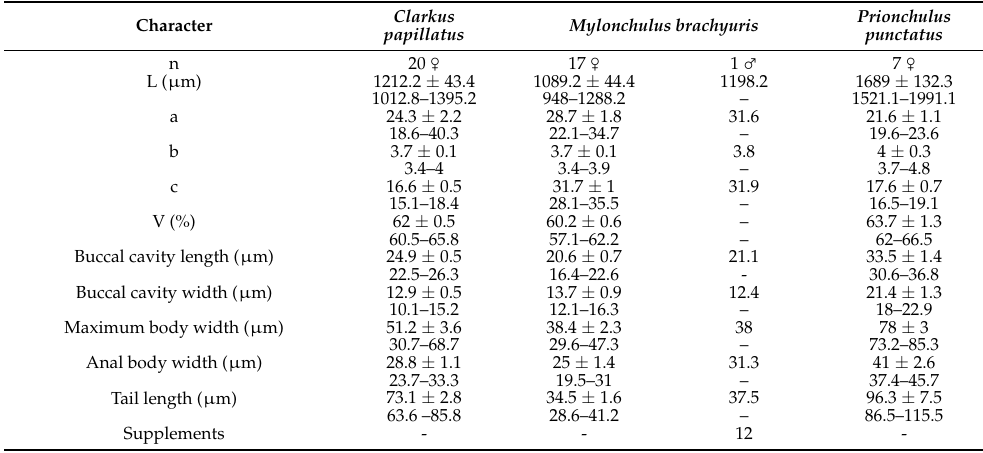
Table 2. Morphometric data of Clarkus papillatus , Mylonchulus brachyuris , and Prionchulus punctatus specimens from open-field tomato plots. Gödöll˝o, Hungary (mean ± CI 95% and range of the measured values. CI 95% means 95% of Confidence